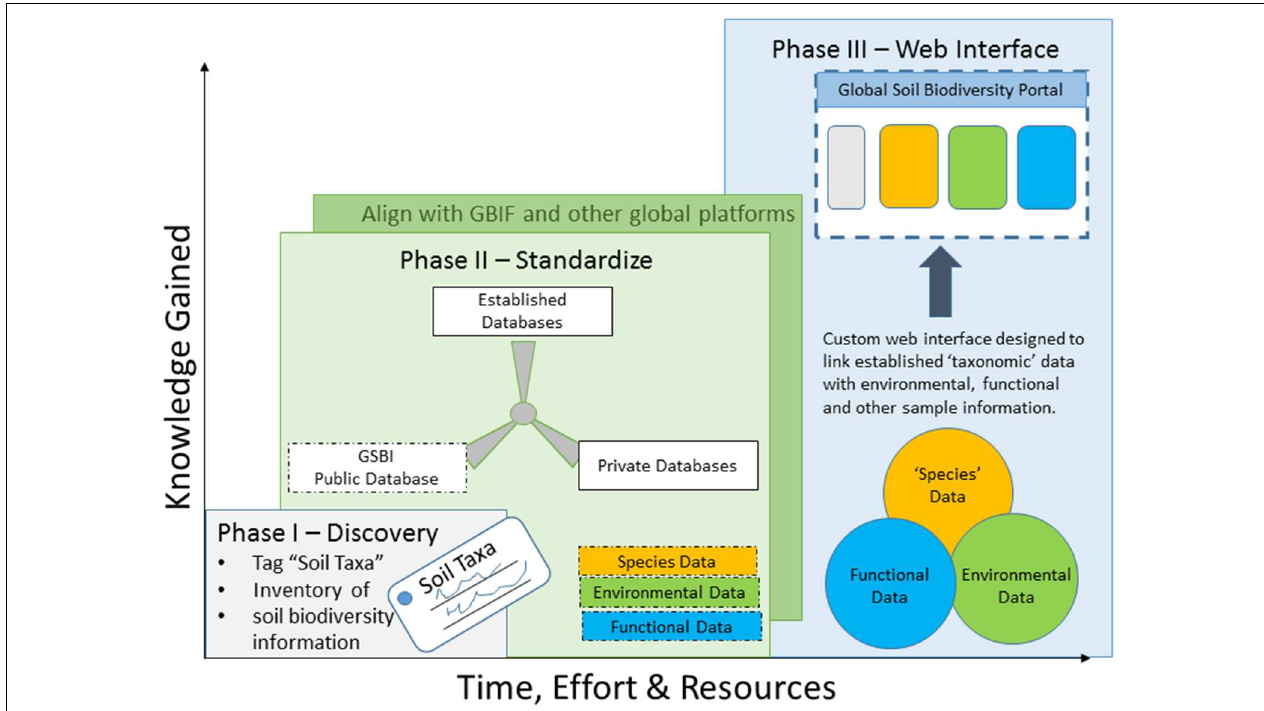
FIGURE 1 | Integration and access to soil biodiversity data will be accomplished in three phases: (I) discovery, (II) standardization, and (III) a final user interface, and the timing of these phases will be directly related to the effort and resources put in to the